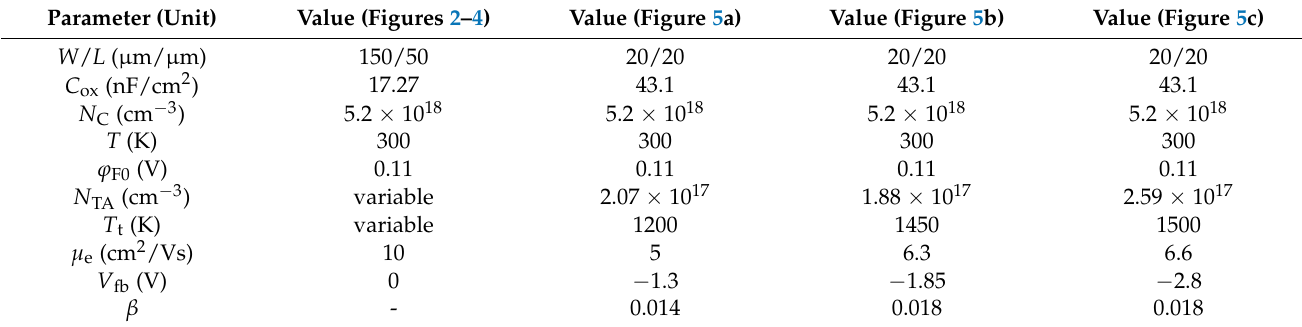
Table 1. Parameters in Figures